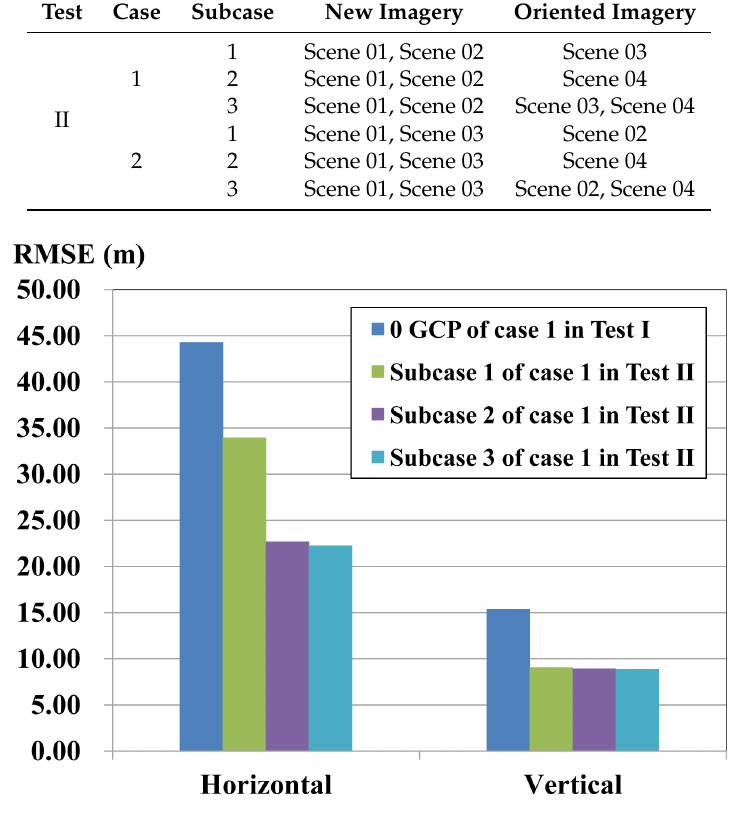
Figure 7. Accuracy Comparison between Case 1 of Test II and Test